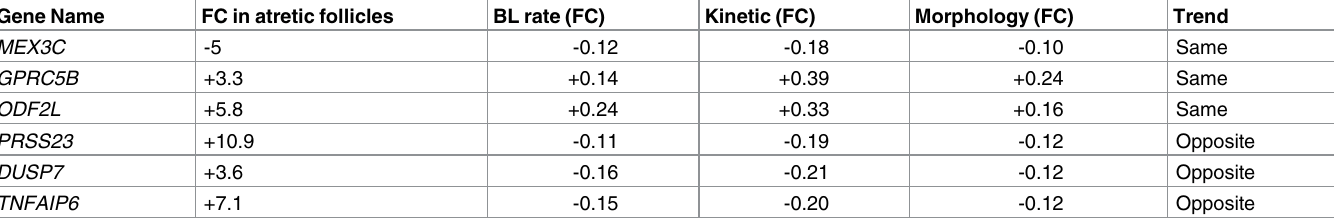
Gene Name = name of the gene, FC = fold change identified in [31], a positive change corresponds to upregulation in small atretic follicles, while negative values correspond to downregulation. FC (BL rate, Kinetic, Morphology) = FC obtained in our study for the corresponding IVP score, Trend = results of the comparison, same trend indicates that the gene follows the same trend as that described in (Hatzirodos et al .(b)) [31] (genes with the same trend resemble the presence of atretic follicles in cows with better IVP